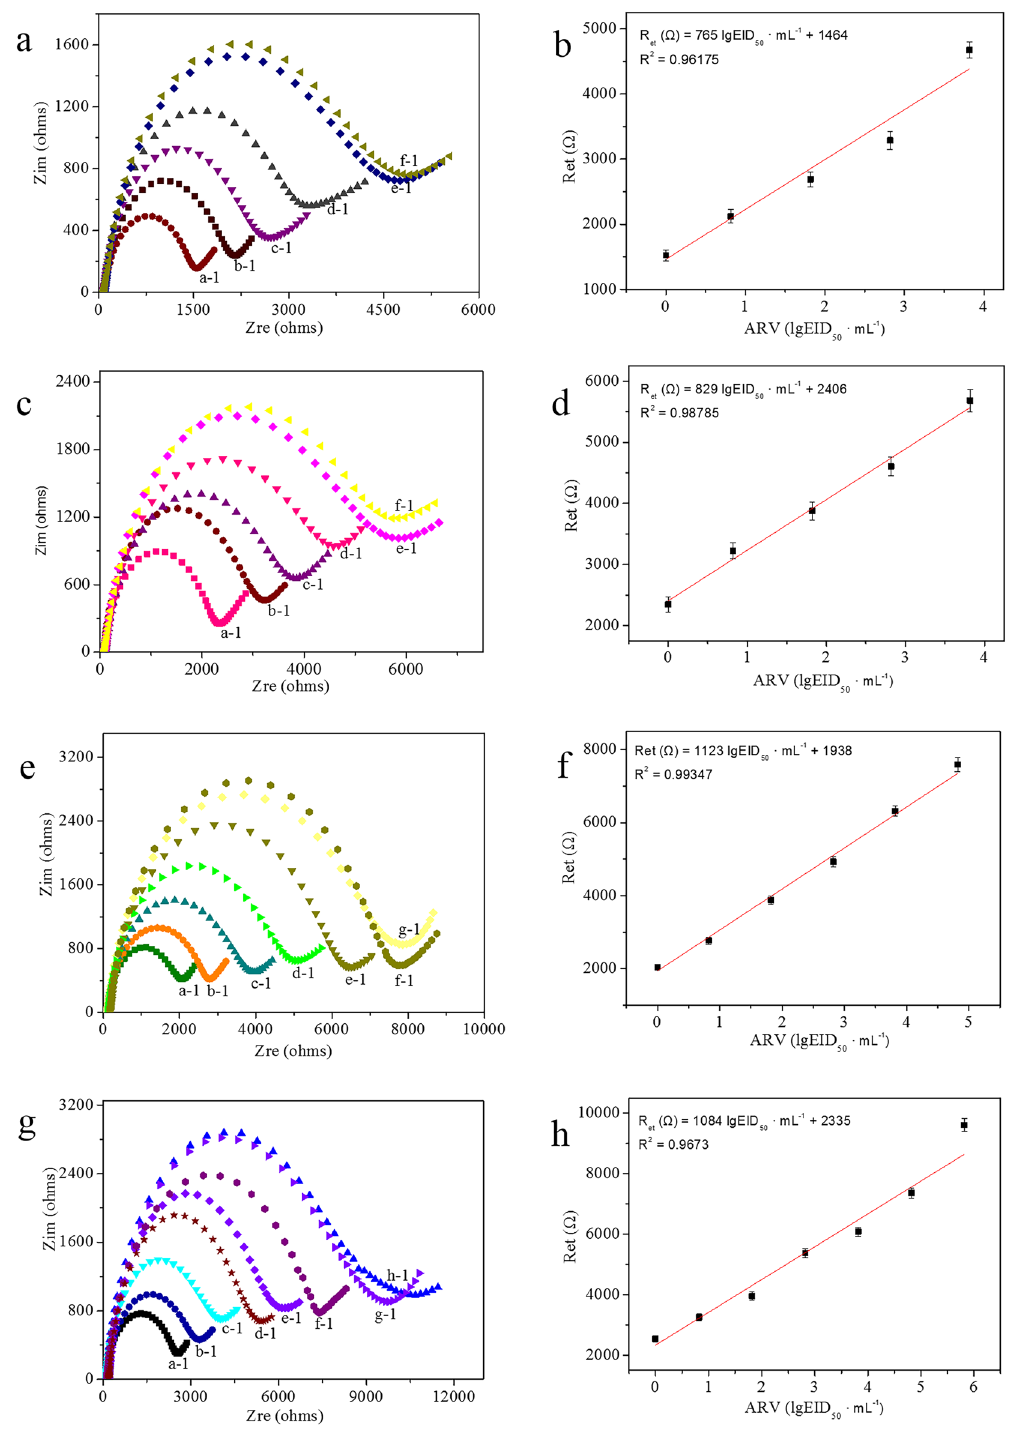
Figure 4. ( a ) Nyquist plots for different concentrations of ARV on GE-G-Chi-Au/PtNP-Glu-ARV/MAb- BSA; ( b ) Calibration curve of GE-G-Chi-Au/PtNP-Glu-ARV/MAb-BSA with different concentrations of ARV. Error bar = RSD (n = 5). ( c ) Nyquist plots for different concentrations of ARV on GE-G-Chi-Au/PtNP-EDC/ NHS-ARV/MAb-BSA; ( d ) Calibration curve of GE-G-Chi-Au/PtNP-EDC/NHS-ARV/MAb-BSA with different concentrations of ARV. Error bar = RSD (n = 5). ( e ) Nyquist plots for different concentrations of ARV on GE-G- Chi-Au/PtNP-ARV/MAb-BSA; ( f ) Calibration curve for GE-G-Chi-Au/PtNP-ARV/MAb-BSA with different concentrations of ARV. Error bar = RSD (n = 5). ( g ) Nyquist plots for different concentrations of ARV on GE-G-Chi-Au/PtNP-CH-ARV/MAb-BSA; ( h ) Calibration curve for GE-G-Chi-Au/PtNP-CH-ARV/MAb-BSA with different concentrations of ARV. Error bar = RSD (n = 5). (a-1) 0, (b-1) 10 0.82 EID 50 mL −1 ARV, (c-1) 10